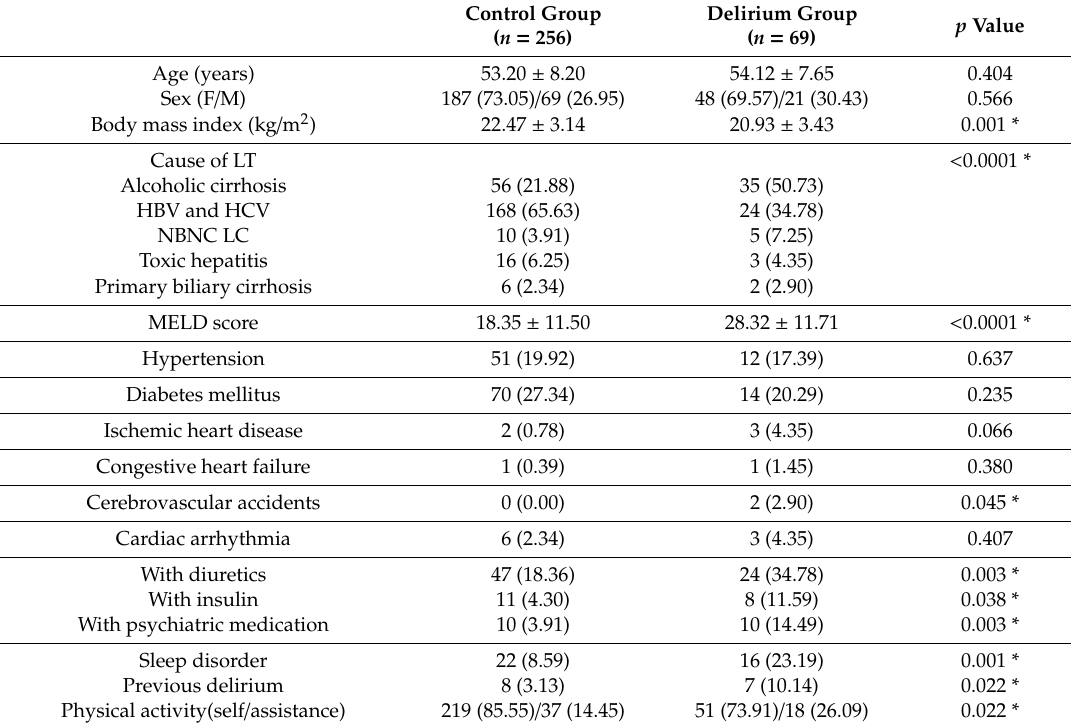
Table 1. Patient characteristics in patients undergoing liver